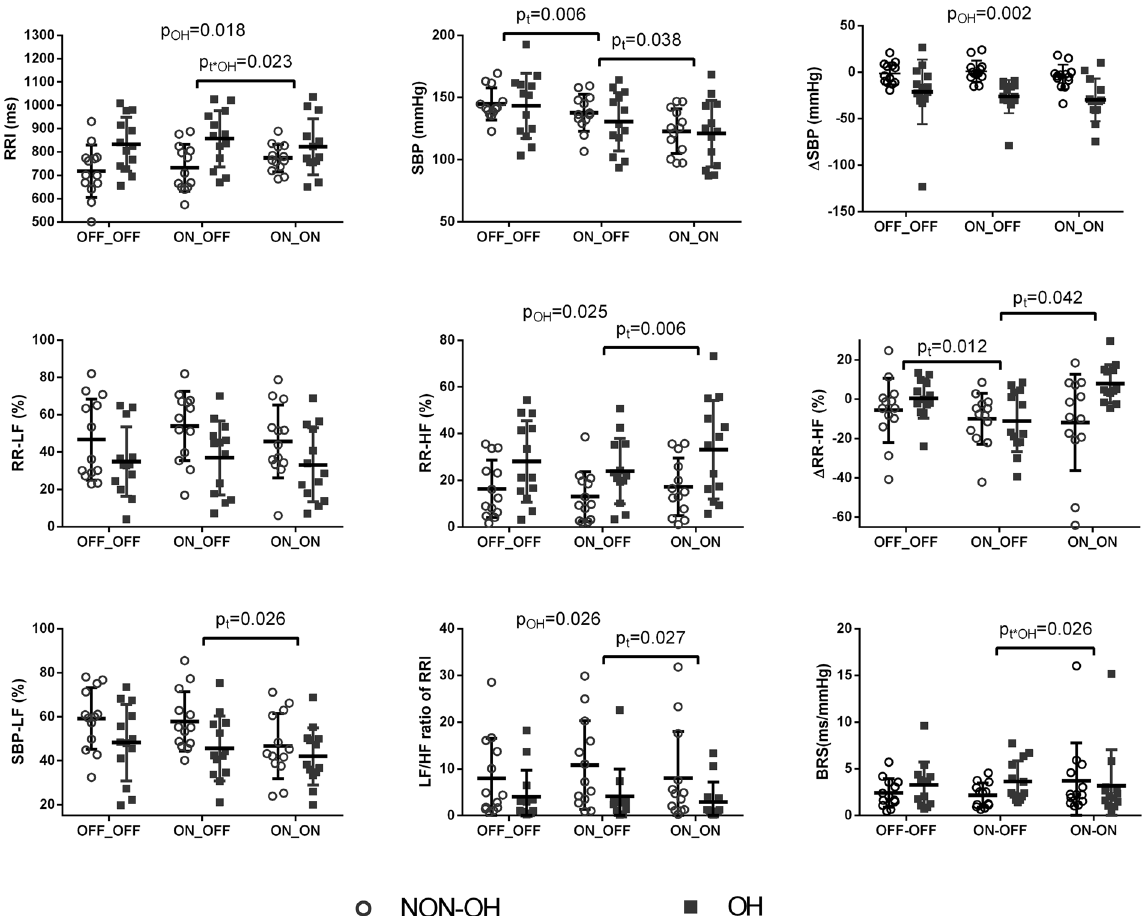
Figure 3. Cardiovascular autonomic function parameters during tilt-up. p t is for repeated measures, p OH for the effect of OH, p t for an interaction between repeated measures and OH. BRS = baroreflex sensitivity, * OH HF = high frequency, LF = low frequency, OH = orthostatic hypotension, RRI = RR interval, SBP = systolic blood pressure; OFF-OFF = both off STN-DBS and off dopaminergic medication, ON-OFF = on STN-DBS and off dopaminergic medication, ON-ON = both on STN-DBS and on levodopa. Data are presented as the mean ± SD, and analyzed by repeated measures